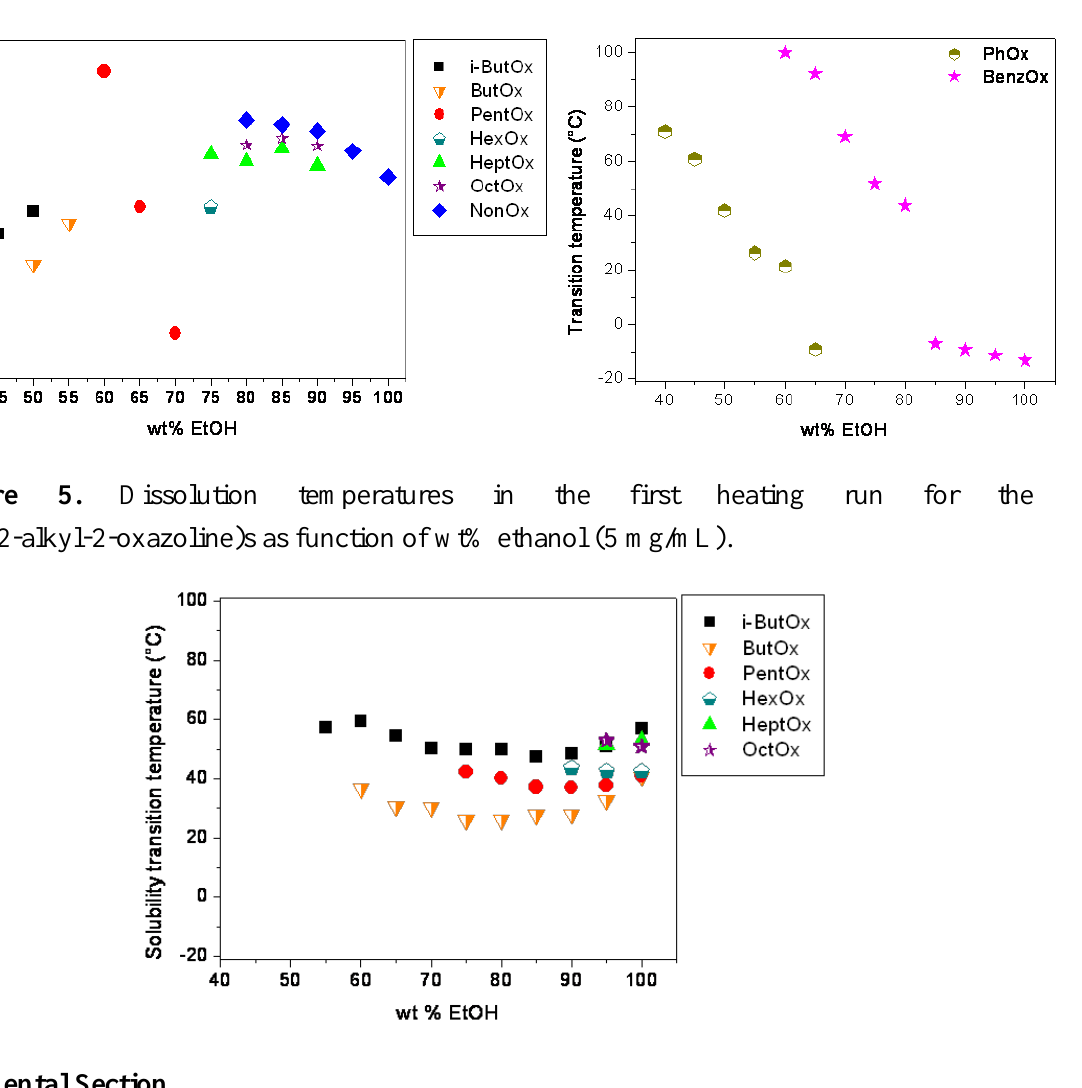
Figure 4. Cloud points as function of wt% ethanol for the UCST transitions of the poly(2-alkyl-2-oxazoline)s (left) as well as poly(2-phenyl-2-oxazoline) (PhOx) and